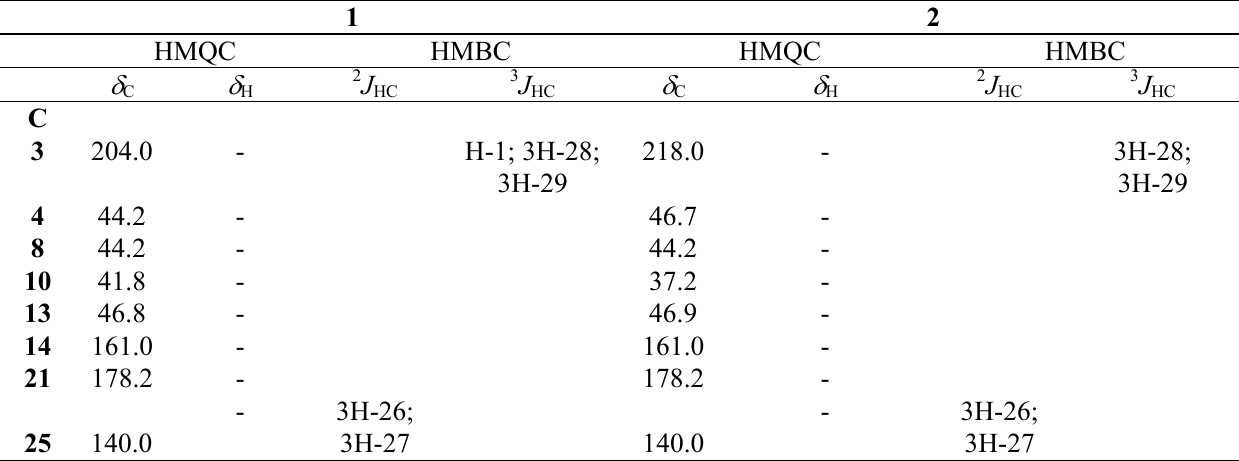
) and HMBC ( n J n = 2 and 3) HC HC